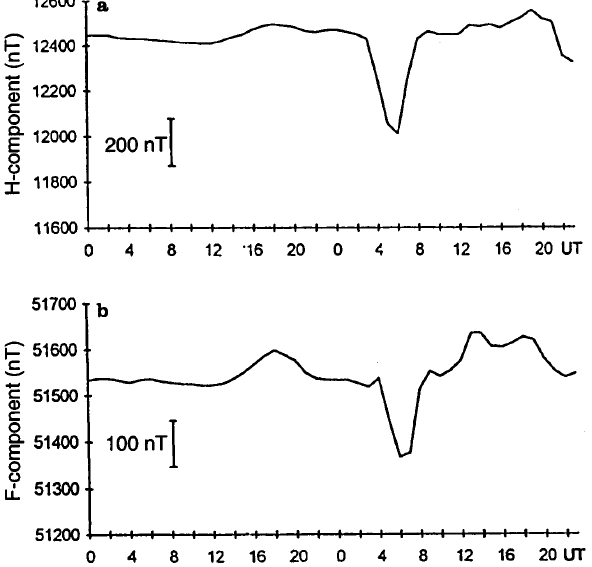
Fig. 6. a H -component variations on 26 and 27 May 1993 and b the magnetic field force for the same period recorded at LVG (dip: 63.41